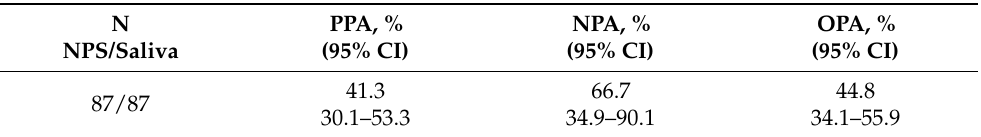
Table 4. PPA, NPA, and OPA between Roche Elecsys Anti-SARS-CoV-2 Antigen results in paired NPS and